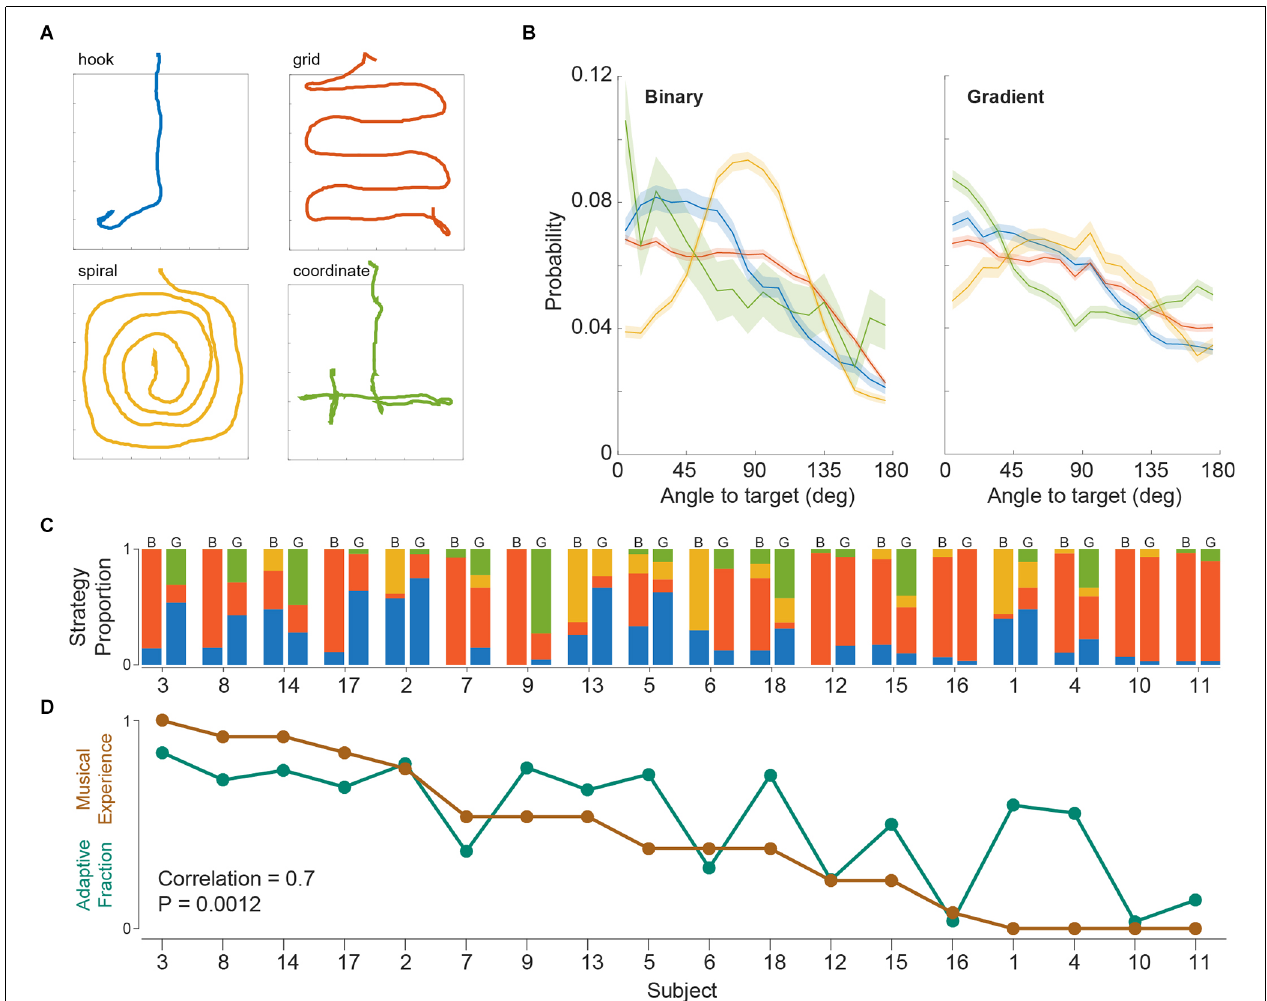
FIGURE 3 | (A) Representative trials of the four stereotypical search strategies. (B) Angle to target histograms across strategies (median and 95% confidence interval). (C) Change in strategy use as a proportion of trials across subjects. Left and right columns per subject represent binary and gradient task versions respectively. Subject order is the same as panel (D) . (D) Fraction of trials of hook + coordinate strategies (Adaptive Fraction), and normalized years of musical experience across subjects, for the gradient task.